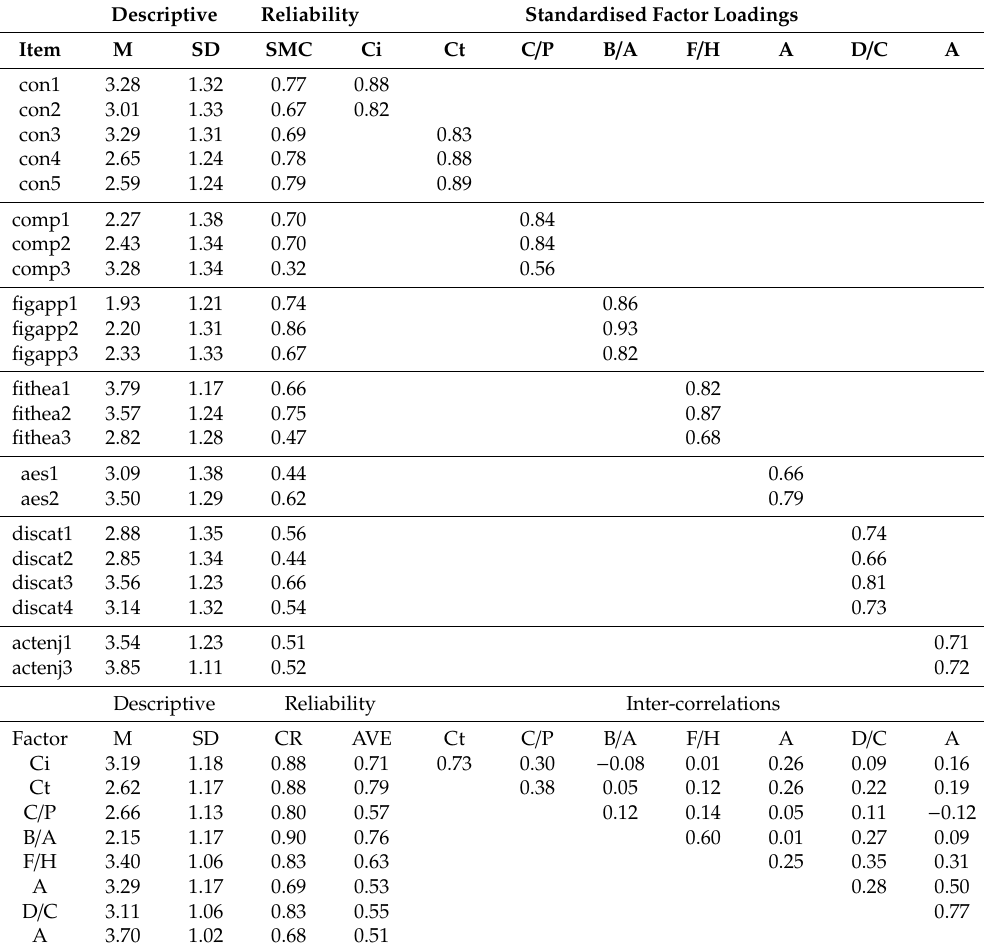
Table 2. Descriptive statistics, factor loadings, factor reliability and correlations.